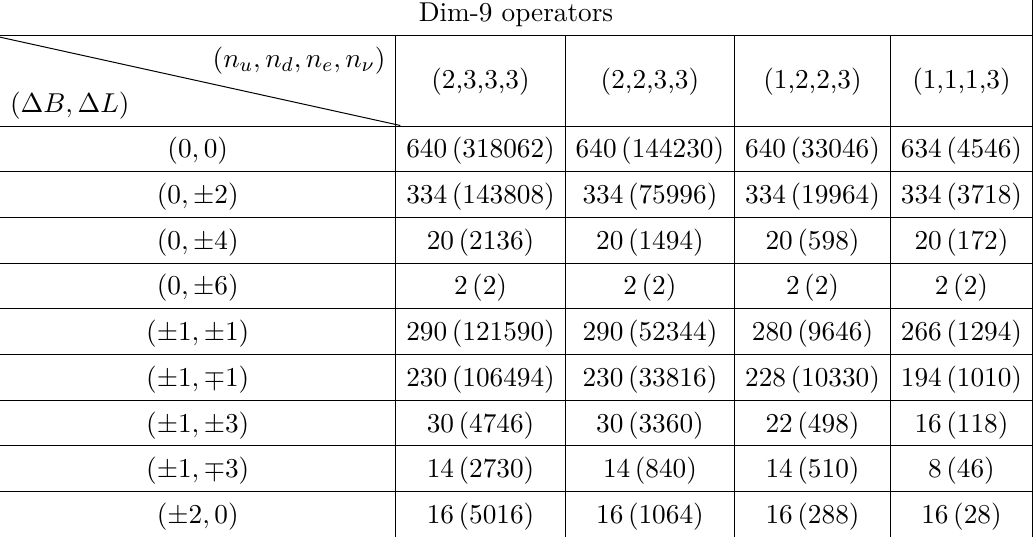
, n , n and n represent active number u d e ν = 2 and u = 3 , 2 , 1 corresponds active e